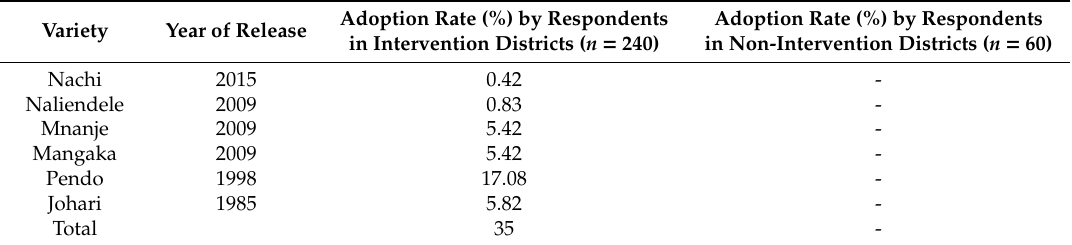
Table 7. Adoption rate per variety among farmers in intervention districts ( n = 300).